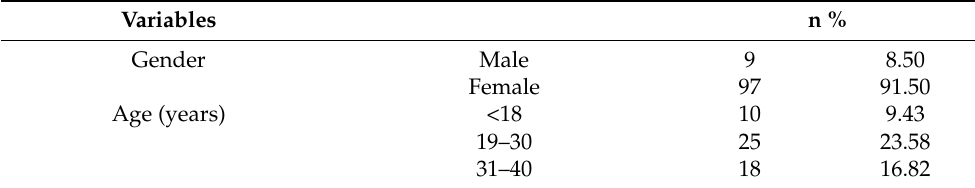
Table 1. Demographic data and disease characteristics of the SLE patients in this